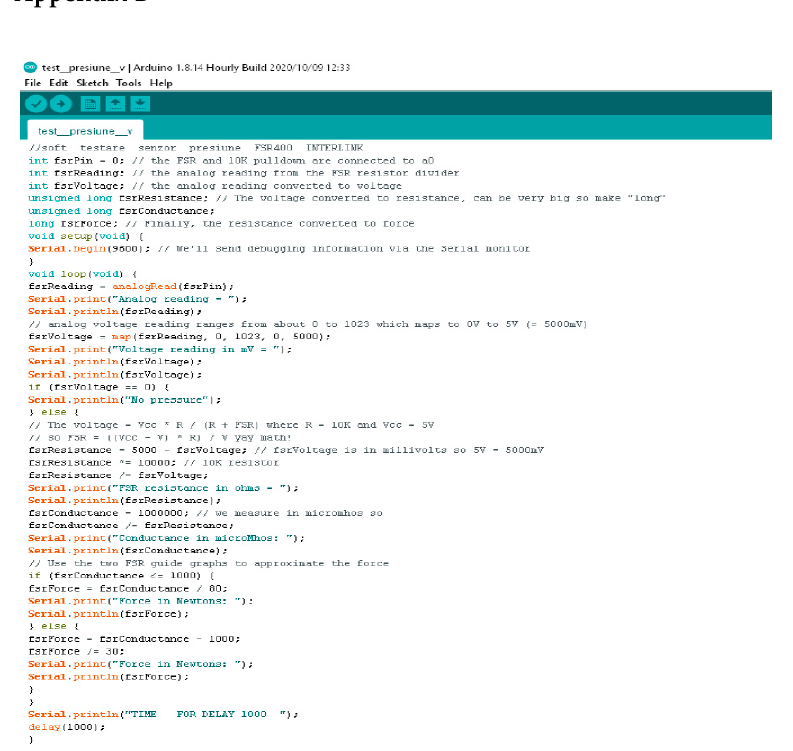
Figure A2. Sensors schematic.